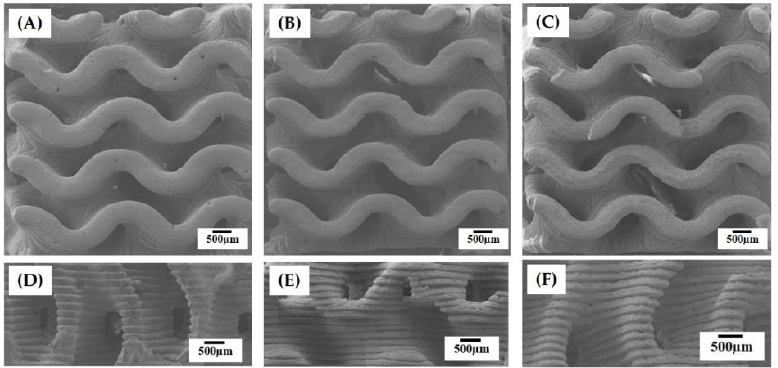
Figure 4. Representative field emission scanning electron microscopy (FE-SEM) images of the hierarchically porous CaP scaffolds manufactured using a range of camphene-camphor amounts of ( A , D ) 40 vol %, ( B , E ) 50 vol %, and ( C , F ) 60 vol %. The top ( A – C ) and bottom ( D – F ) images display the structures developed normal and parallel to the building direction.